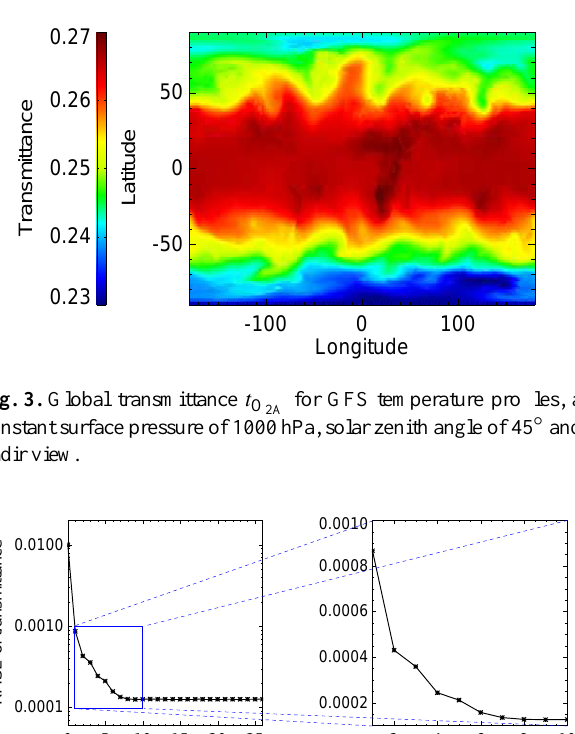
0 Fig. 4. Global root mean square error of approximated transmittance Figure 4: Global root mean square error of approximated transmittance between between 760 and 763nm for a surface pressure of 1000hPa and an 760 and 763nm for a surface pressure of 1000hPa and an airmass of 2.41, as a airmass of 2.41, as a function of the number of eigenvectors used. function of the number of eigenvectors used. 0 profile, resulting in regional surface pressure biases of up to 50 hPa, as shown in Fig. 6, left Figure 4: Global root mean square error of approximated transmittance between 760 and 763nm for a surface pressure of 1000hPa and an airmass of 2.41, as a function of the number of eigenvectors used.